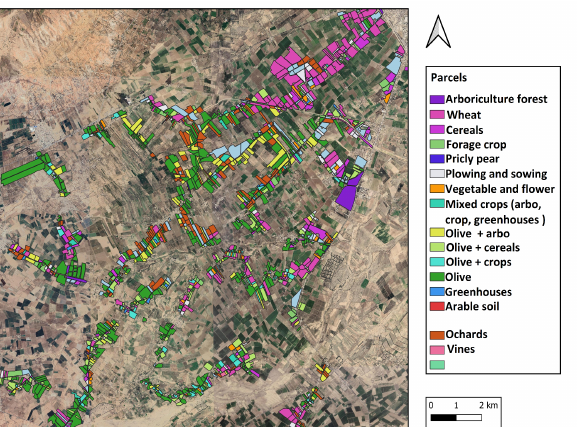
Figure 6. Spatial distribution of observed parcels in field mission - Kairouan site